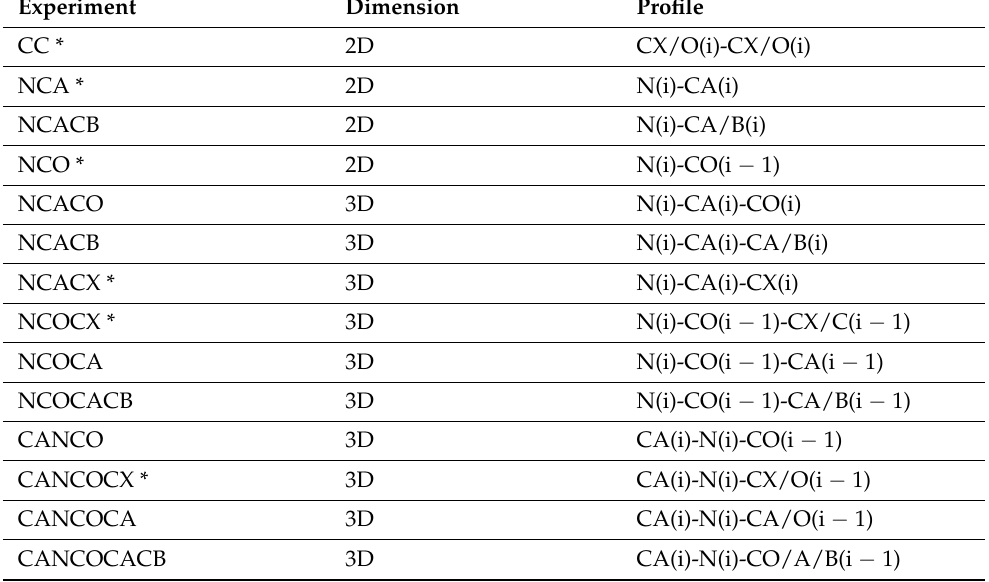
Table 1. ssNMR experiments supported by ssPINE with their dimensionality and connectivity profiles. CX(i) represents carbon A, B, D, E, G, or H atoms of the ith residue; N(i) represents the nitrogen atom of the ith residue; and CO(i − 1) represents the carbon atom of the carboxyl group of the preceding residue. The minimum set of experiments needed is indicated by asterisks. Experiment Dimension Profile CC